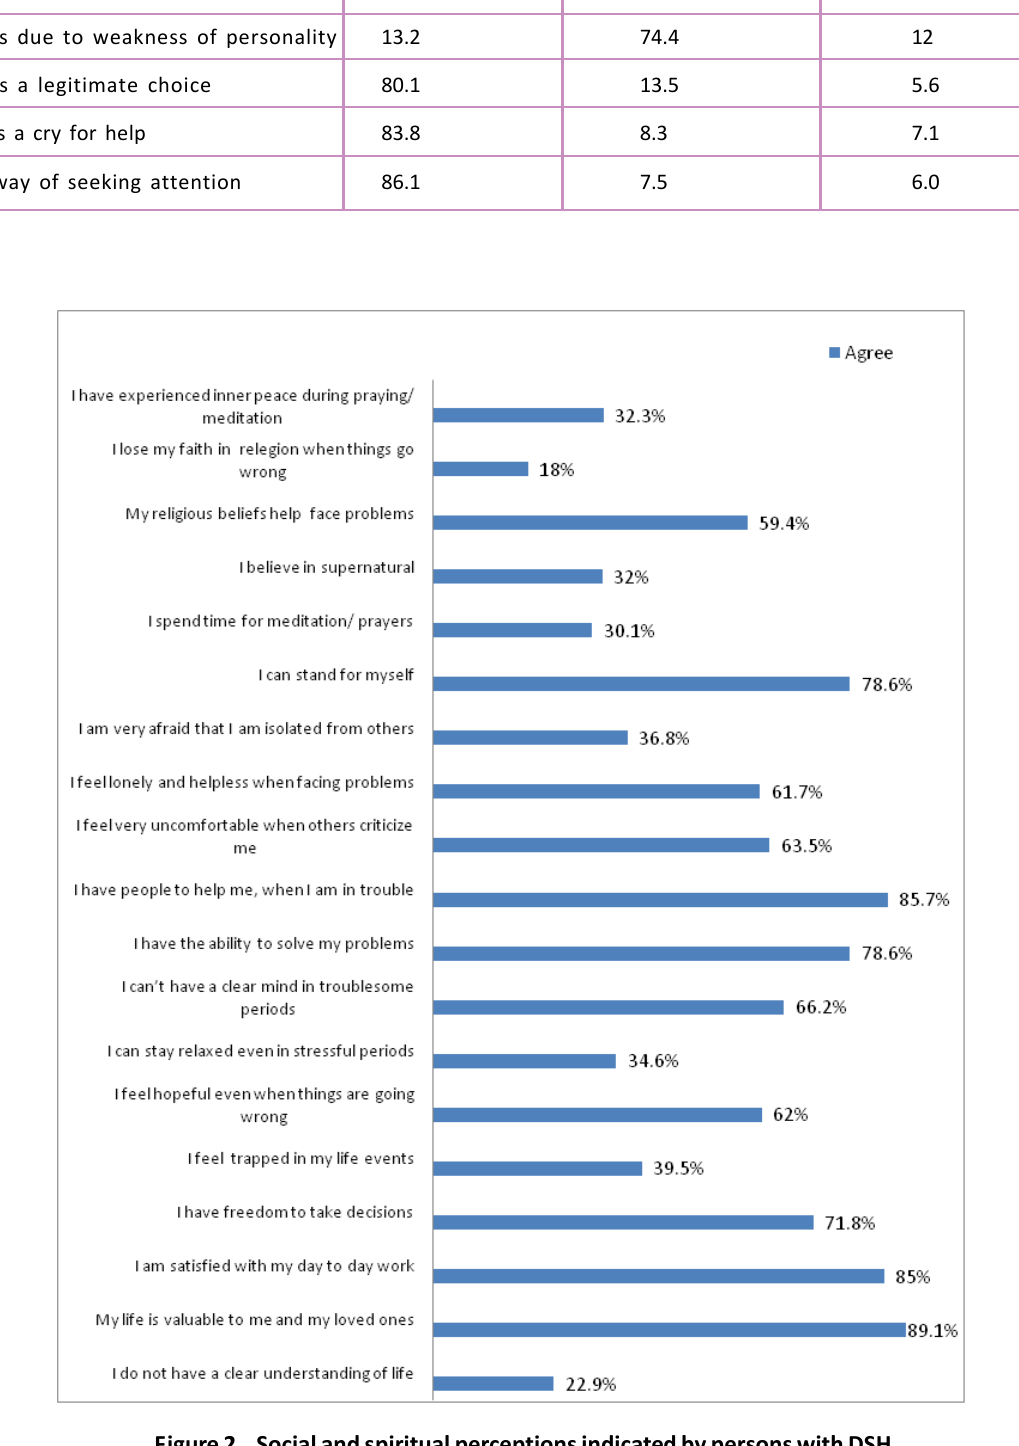
Figure 2. Social and spiritual perceptions indicated by persons with